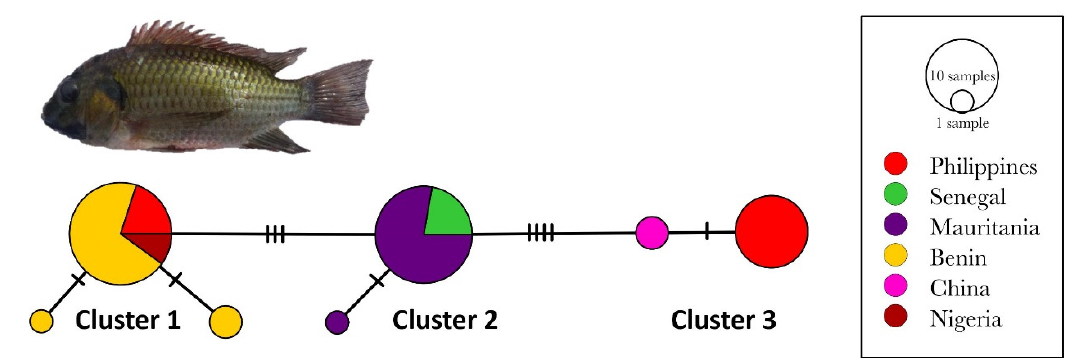
Figure 3. Minimum spanning network constructed from COI sequences of S. melanotheron obtained in our study and from GenBank. Colours denote countries where specimens were sampled, node size the number of sequences in a haplotype. The photograph represents a specimen of S. melanotheron from the Atchakpa reservoir (Photo credit: R.O.E. Pèlèbè).